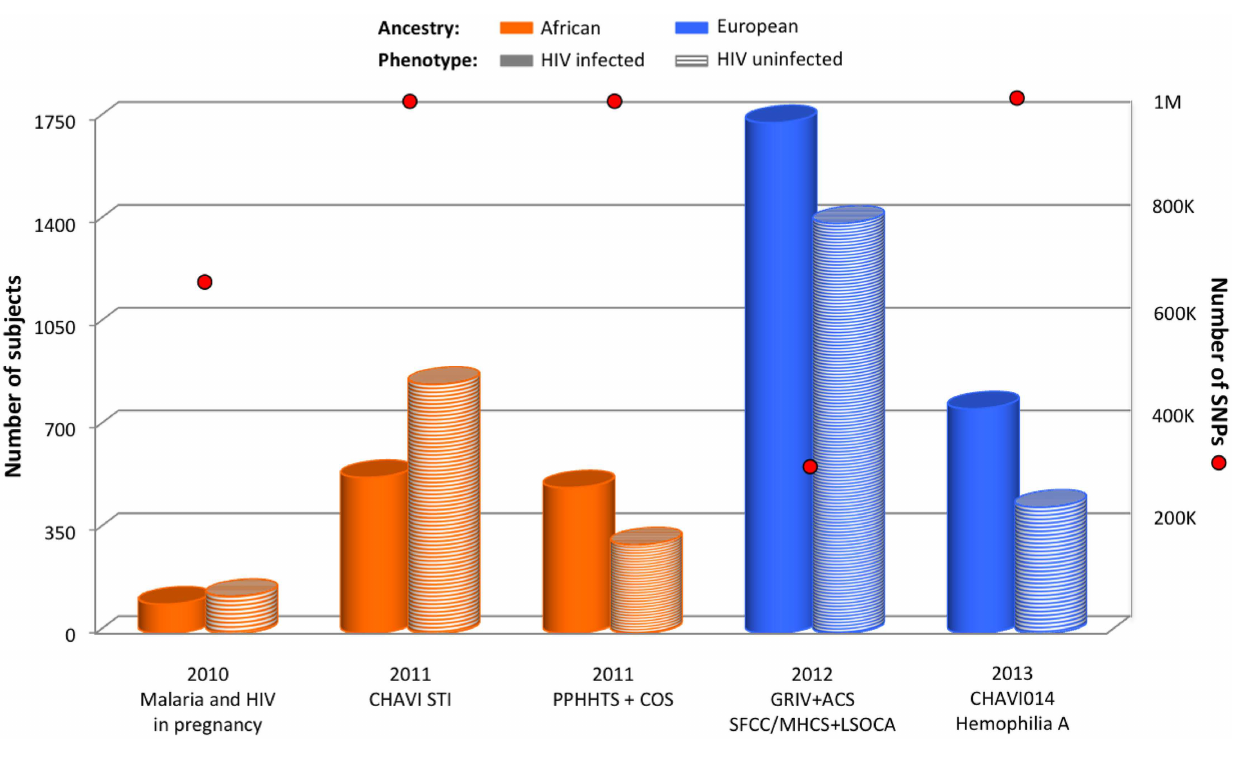
FIGURE 4 | Summary of GWAS design focusing on HIV acquisition . The histogram presents the number of subjects and red circles display the number of SNPs covered by the genotyping arrays. Individual ancestry is